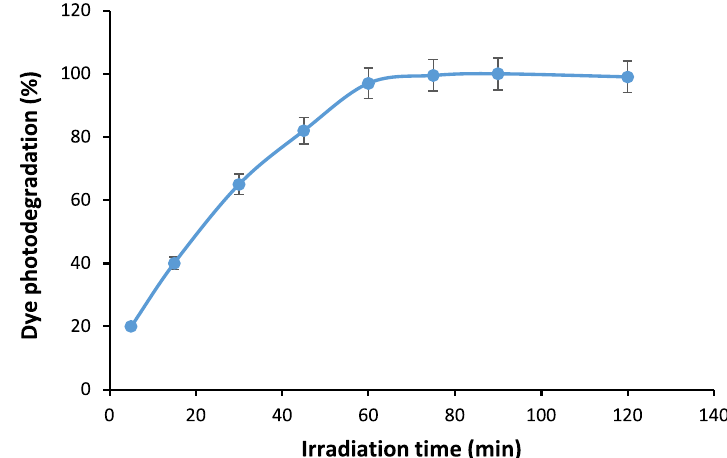
Fig. 8 Effect of the irradiation time on the dye photodegradation over TiO 2 – Fe (1:0.5) under visible light. (Dye concentration 10 mg/L, dye solution volume =